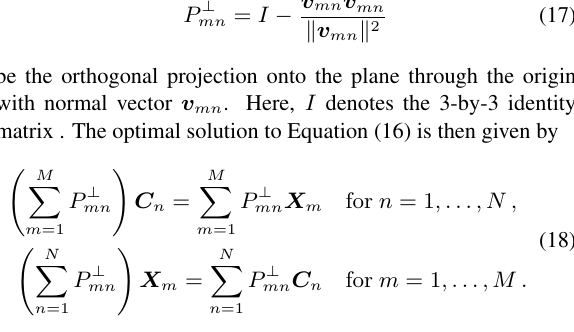
Figure 5. Perspectively distorted square.